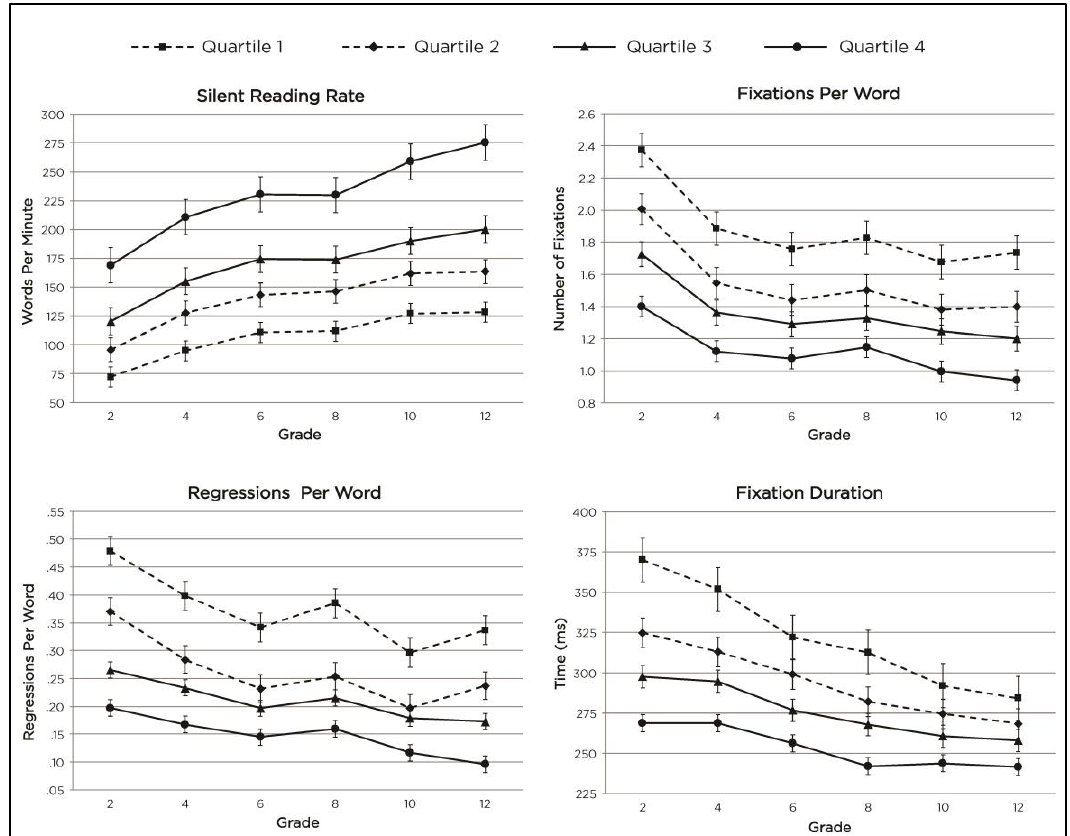
Figure 1. Reading Efficiency Measures Across Grades and Reading Rate